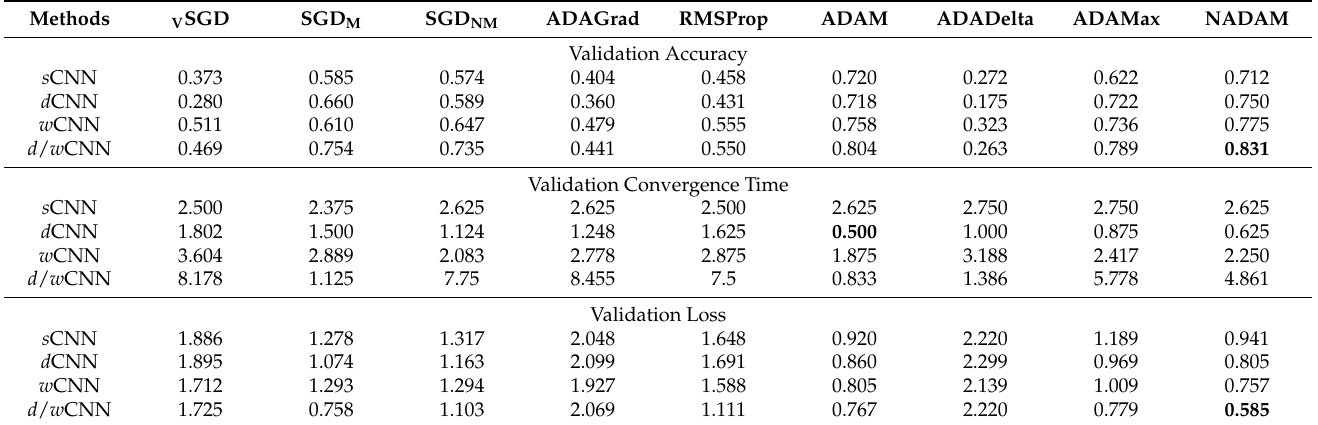
Table 10. Results of optimizers with CNN architectures on Fashion MNIST (epoch =